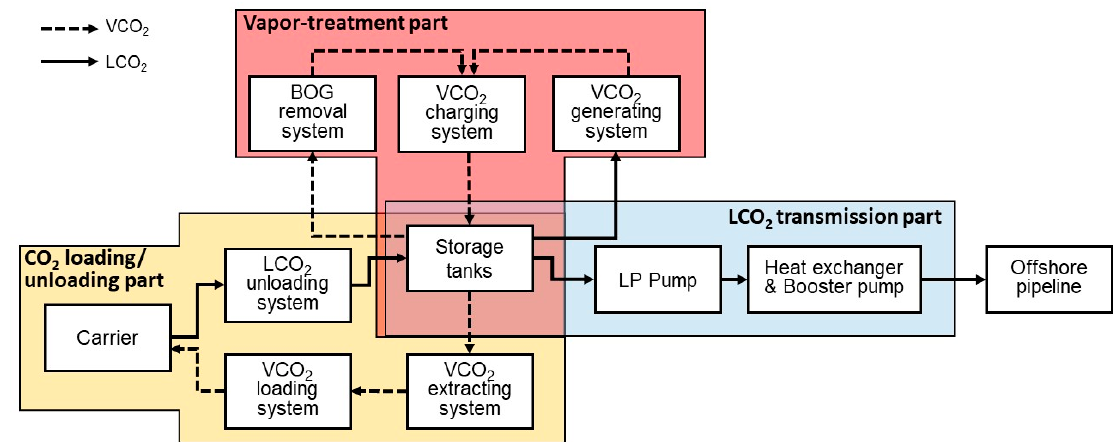
Figure 8. The process flow block diagram of the CO 2 terminal. The yellow, red, and blue parts represent the CO 2 loading/unloading, vapor-treatment, and LCO 2 transmission parts, respectively. Energies 2019 , 12 , x FOR PEER REVIEW